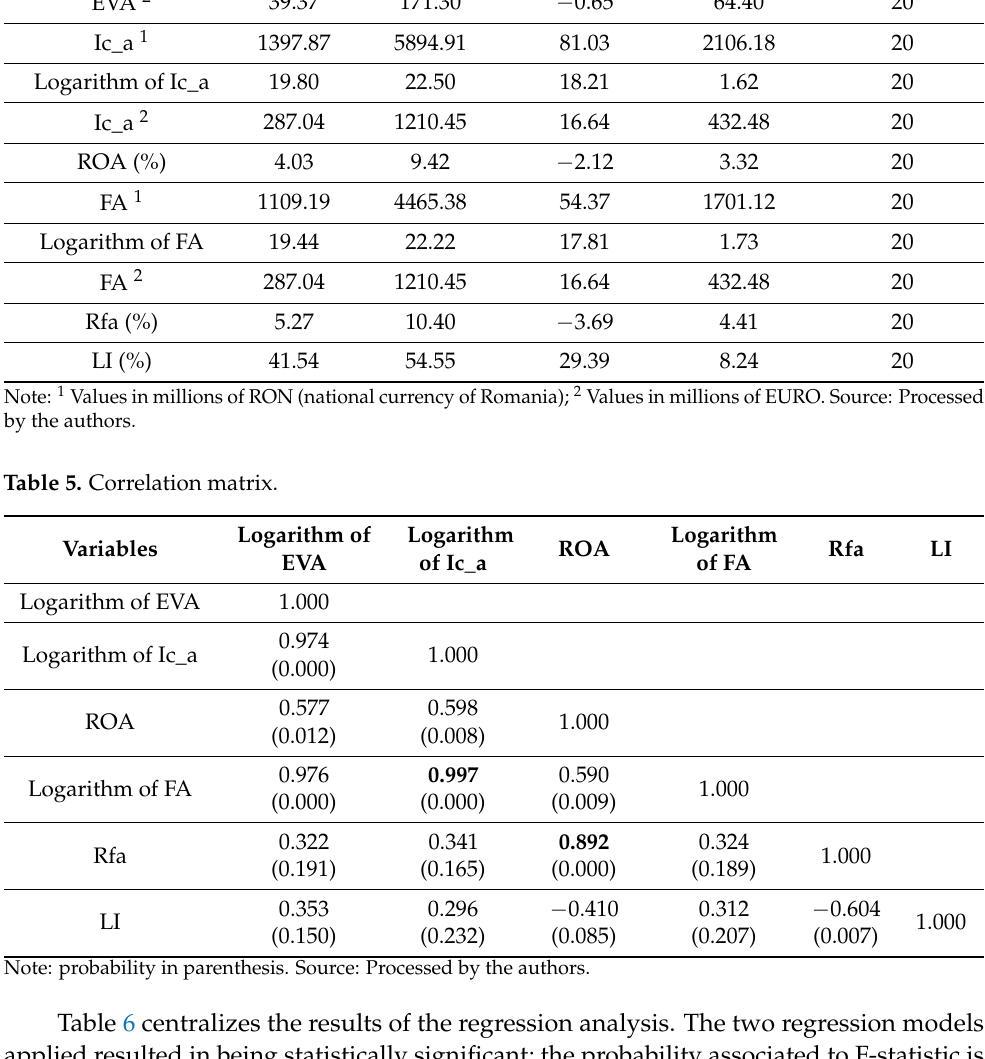
Table 4. Descriptive statistics of the variables included in the analysis. Mean Maximum Minimum Std. Dev. Observations